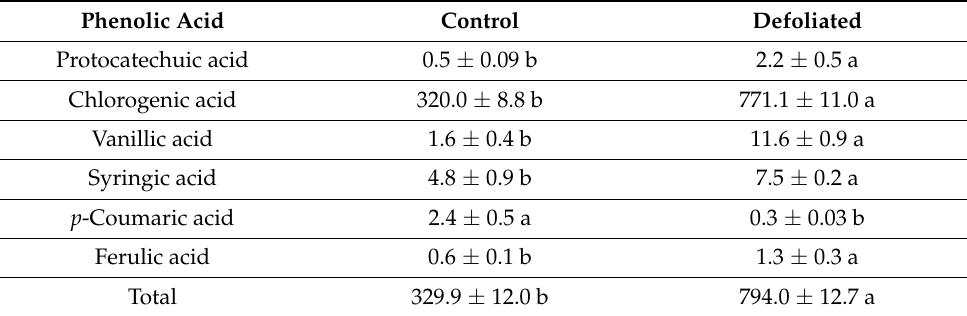
Table 1. Free phenolic acids ( µ g g − 1 fresh weight) in grape berries from control and defoliated vines of Vitis vinifera (Trebbiano variety). Data are reported as mean values ± standard error. For each compound means accompanied by different letters are significantly different at p ≤ 0.05.